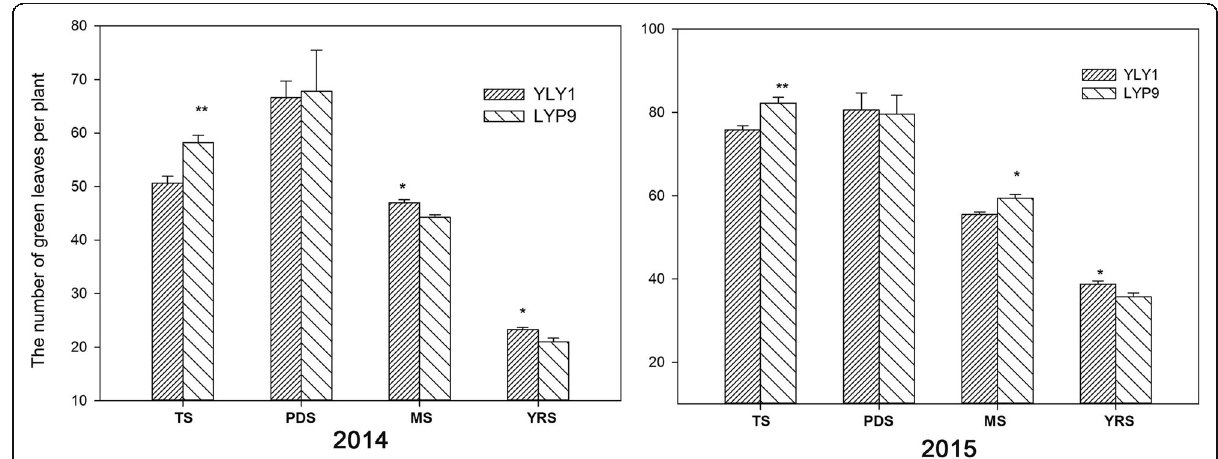
Fig. 4 The number of green leaves per hill during the growth season in 2014 and 2015. TS: tillering stage; PDS: panicle differentiation stage; MS: milk stage of grain filling; YRS: yellow ripe stage, “ *, ” “ ** ” represent significance levels of p = 0.05 and p = 0.01 levels, respectively. The bar represents the standard deviation of 10